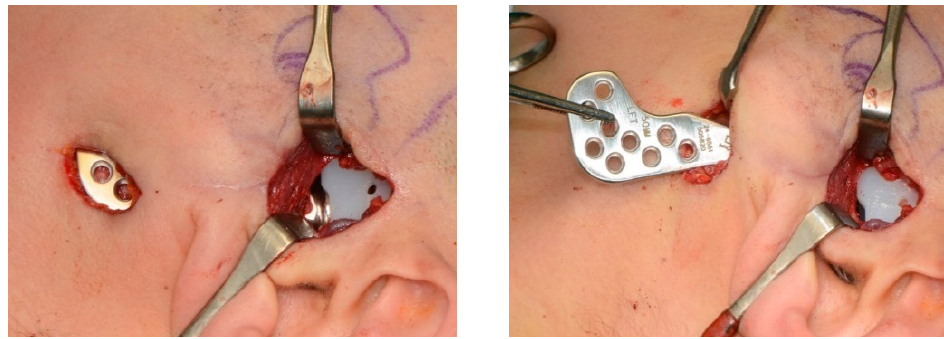
Figure 1. Surgical view for alloplastic total TMJ replacement.